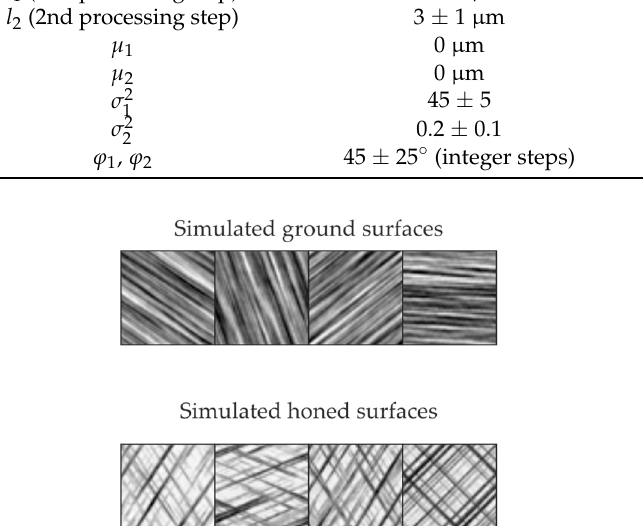
Figure 5. Examples of simulated ground ( top ) and honed ( bottom ) surfaces as compressed grayscale grayscale images.